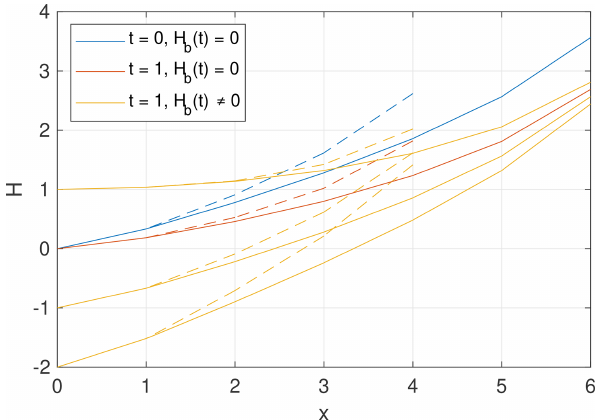
Figure 1. River profiles obtained from one implicit time step, where all parameters ( K , δt , grid spacing) are set to unity. The blue line describes a steady state with U = 1, and it is assumed that U = 0 for t >